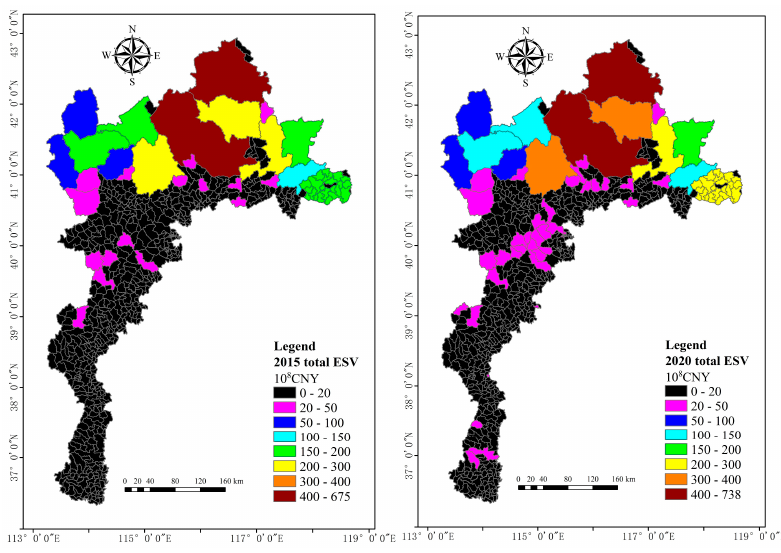
Figure 4. Spatial distribution of the total ESV at township scale in 2015 and 2020.